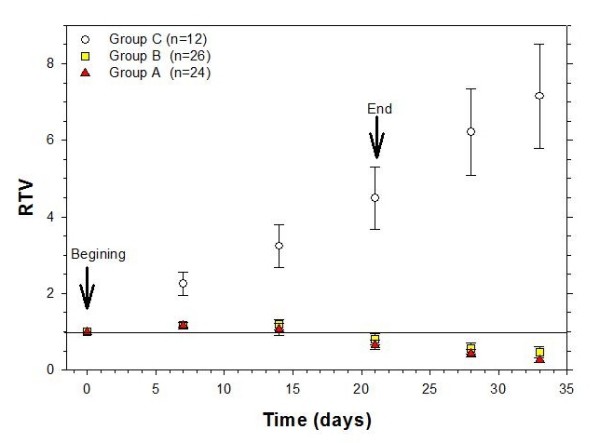
Therapeutic response (Relative Tumor Volume vs. Time) for the control and the experimental groups. Group A: cervical cancer xenografts treated with radiotherapy, cisplatin and gemcitabine as explained in the text; Group B: xenografts treated with radiotherapy and gemcitabine; Group C: untreated xenografts controls. Arrows indicate beginning and end of the treatments. Solid line signals RTV = 1, i.e. no change in tumor volume. Values are given as means ± SEM.